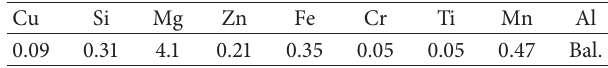
Table 1: Chemical compositions of the 5083 aluminum alloy (wt.%).